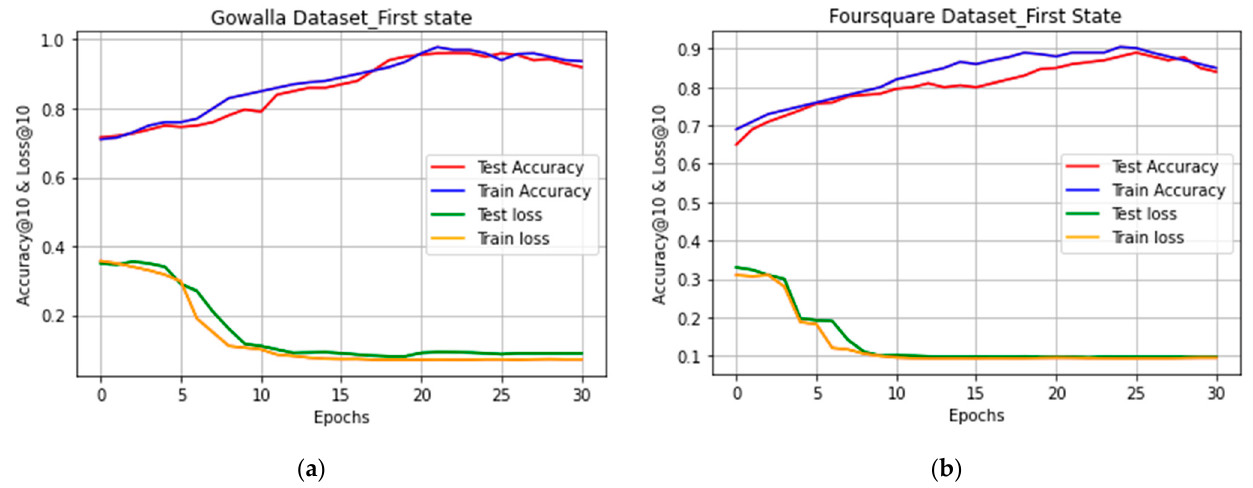
Figure 8. Training and testing accuracy @10 and loss @10 for two datasets vs. epochs in the first state of experiments. ( a) Gowalla dataset; ( b ) Foursquare dataset.